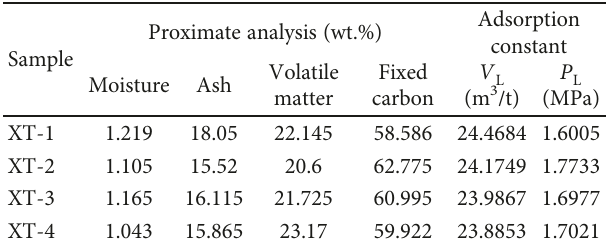
Table 1: Proximate analysis and adsorption constant of coal samples. Proximate analysis Sample